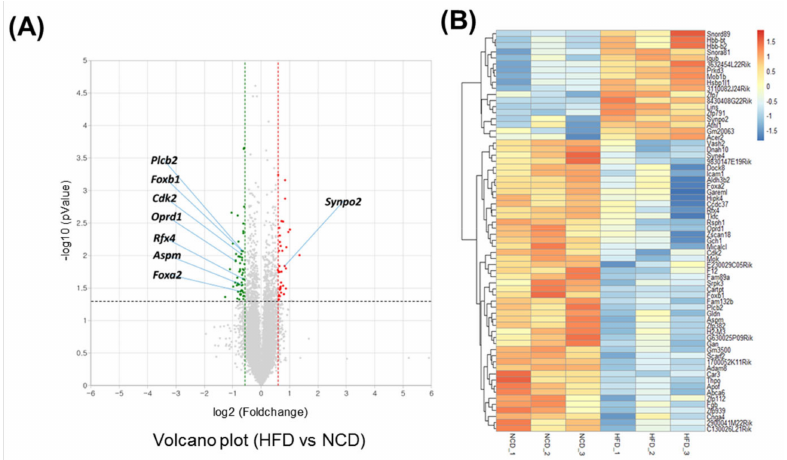
Figure 1. Transcriptome analysis of the brain under short-term HFD feeding. ( A ) Volcano plot analysis of differentially expressed genes (DEGs) after 10 days HFD feeding in which the red and green dot represent fold change > 1.5 and p value < 0.05 expression, namely the differential metabolites screened by univariate statistical analysis. ( B ) Heatmap of the significant differential expression